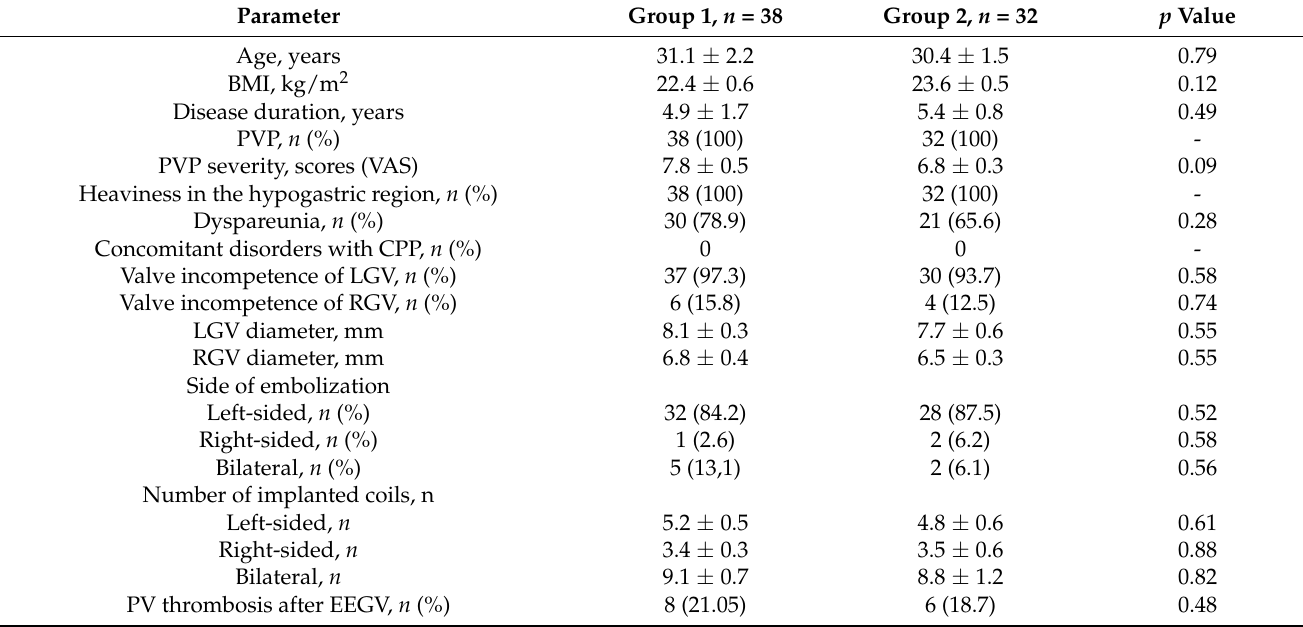
Table 1. Baseline characteristics of groups and technical characteristics of